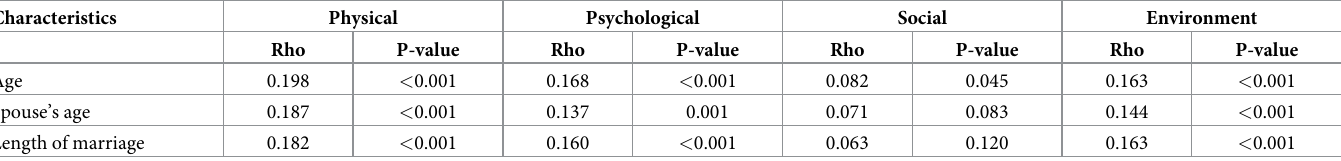
Table 3. Spearman correlation test between quality of life domains and age and length of the marriage.